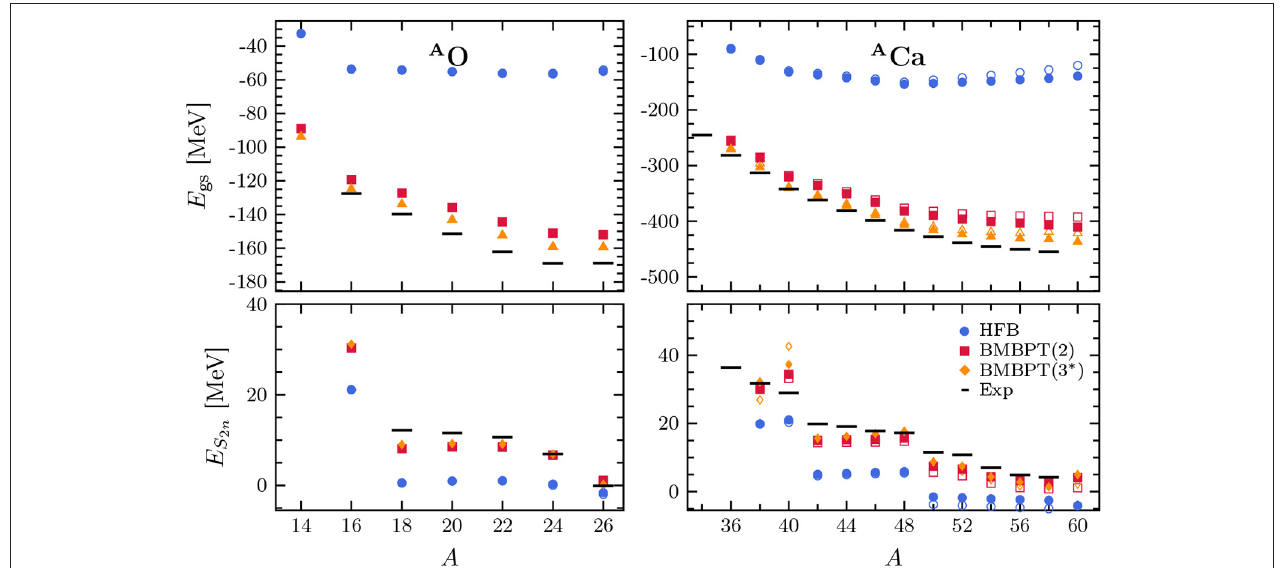
FIGURE 14 | BMBPT systematics along O (left) and Ca (right) isotopic chains using the non-local chiral two- plus three-nucleon interactions at N 3 LO presented in Hüther et al. [115]. Top panel: absolute binding energies. Bottom panel: two-neutron separation energies. Plot markers correspond to HFB ( l ), second-order BMBPT ( (cid:4) ), and third-order BMBPT ( (cid:4) ). All calculations are performed using 15 oscillator shells and an oscillator frequency of ¯ h ω = 20MeV. The single-particle orbital angular-momentum quantum number was limited to l ≤ 10. Open and closed symbols correspond to different truncations E 3max = 14,16, respectively.